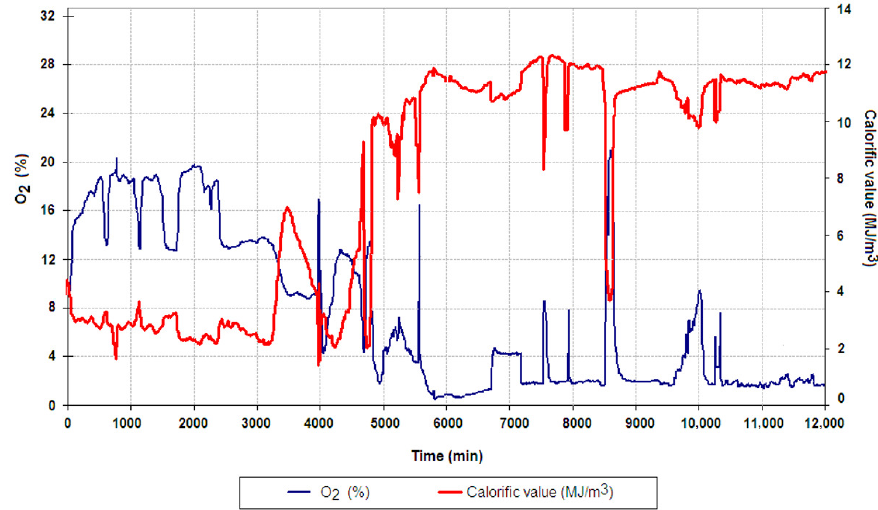
Figure 6. The effect of reducing oxygen in syngas on its calorific value